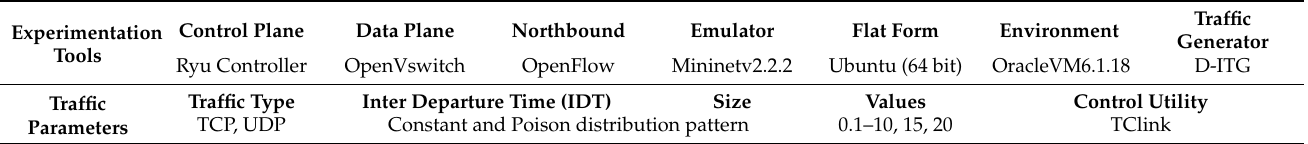
Table 2. Experimentation Tools and Data Traffic